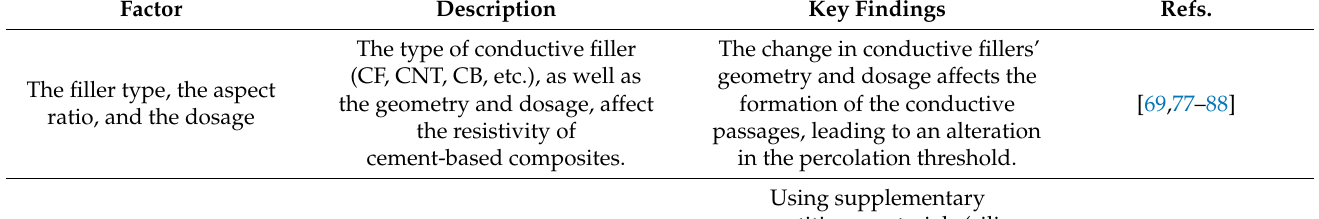
Table 1. Factors affecting resistivity and piezoresistivity measurement in self-sensing concrete. Description Key Findings Refs.